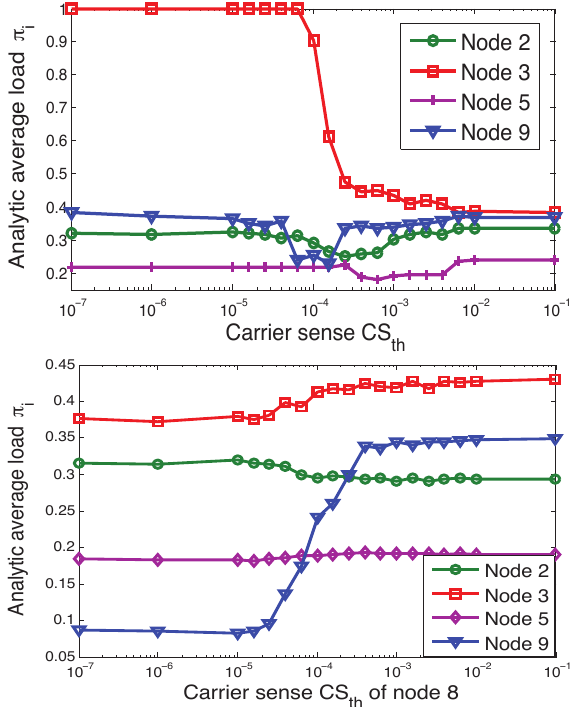
Figure 11. Average load of forwarding queues from model versus simulation for variable carrier sense threshold (in Watt).